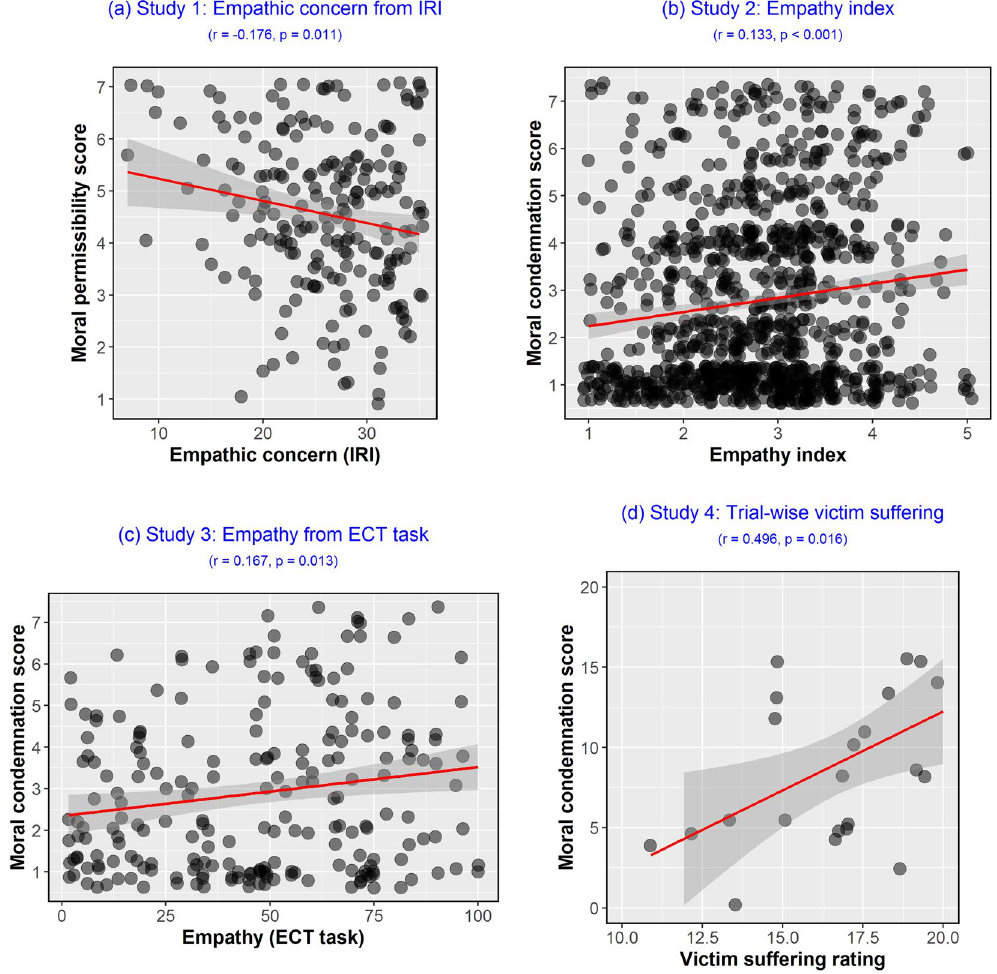
Figure 1. Positive relationship between empathy and condemnation of accidents. Behavioral studies 1–4 revealed that individuals who scored high on empathy, as assessed using ( a ) empathic concern (EC) subscale of Interpersonal Reactivity Index (IRI), ( b ) Empathy index measure, ( c ) empathy scores from the Empathy- Compassion Task (ECT), and ( d ) trial-by-trial victim suffering ratings, condemned accidental harm-doers more severely. Different questions were asked across studies 1–4: ( a ) moral permissibility, ( b , c ) wrongness and punishment, and ( d ) acceptability and